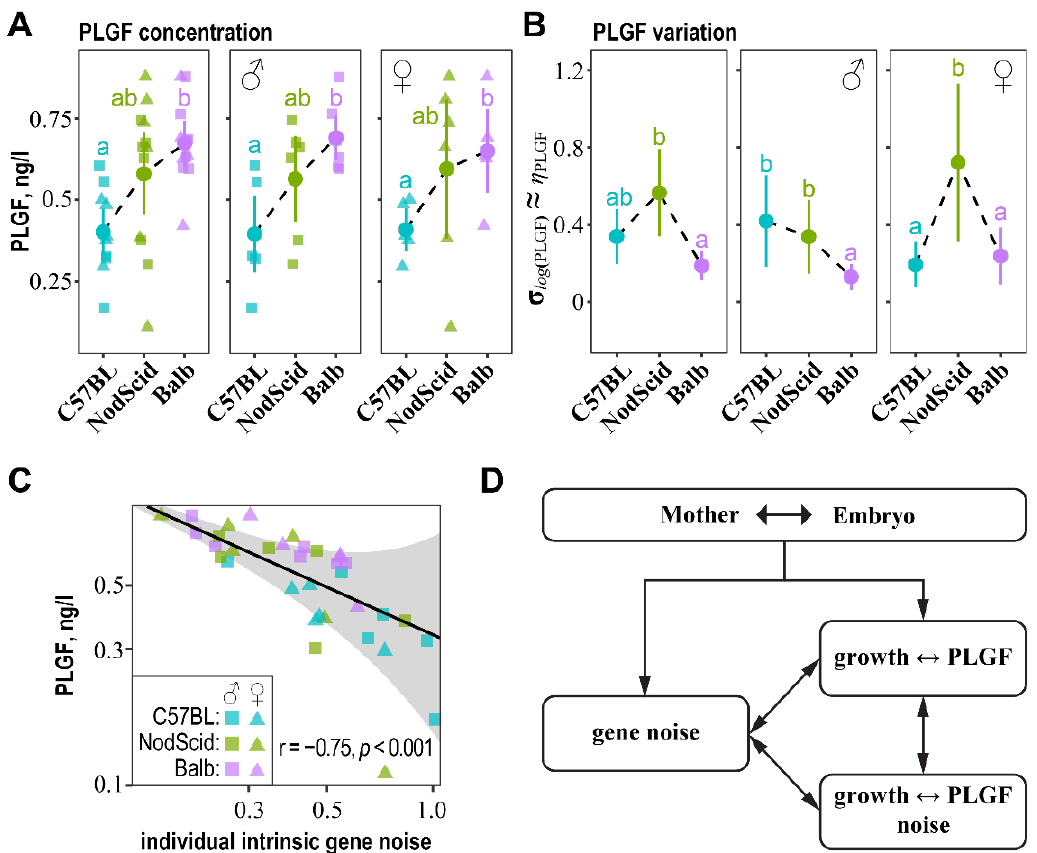
Figure 4. Relationships between PLGF, PLGF noise, and pulled “intrinsic” gene noise. ( A ) PLGF concentrations in placentas of C57BL/6J embryos developed in C57BL/6J, NOD-SCID, and BALB/c surrogate mothers on day 16.5 of pregnancy. Circles indicate means, whiskers—95% confidence intervals, and letters—significant differences at FDR < 0.05. ( B ) GAMLSS estimations of noise in PLGF concentrations. Circles indicate ˆ σ log ( PLGF ) ≈ ˆ η PLGF , whiskers—95% confidence intervals, and letters—significant differences at FDR < 0.05. ( C ) GAMLSS model of the relations of placental PLGF ( log ( PLGF ) ) with individual estimates of the pulled “intrinsic” gene noise ( η int . ). Grey ribbon indicates a 25–75 centile region. Correlation is shown in the bottom-right corner; the model coefficients are given in Table S4. ( D ) A model depicting the cross-talk between transcriptional stability (gene noise), PLGF levels, embryonic growth, and fluctuations in PLGF and embryonic growth mediated by mother–fetus MHC immune interactions (see main text for